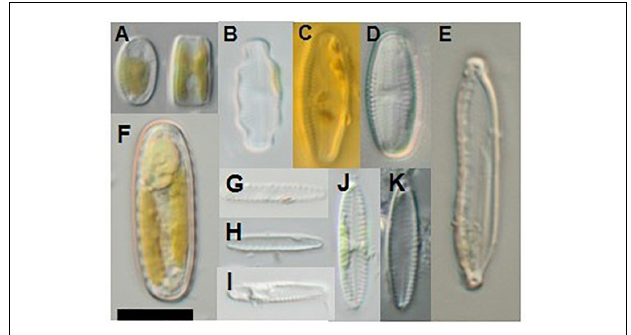
FIGURE 4 | Diatom morphotypes observed directly in rewetted biocrust material. (A) Cymbellaceae ; (B) Luticola cf. nivalis ; (C,D) Luticola sp.; (E) Hantzschia sp.; (F) Surirella sp.; (G–K) Navicula sp.; scale bar indicates 10 µ